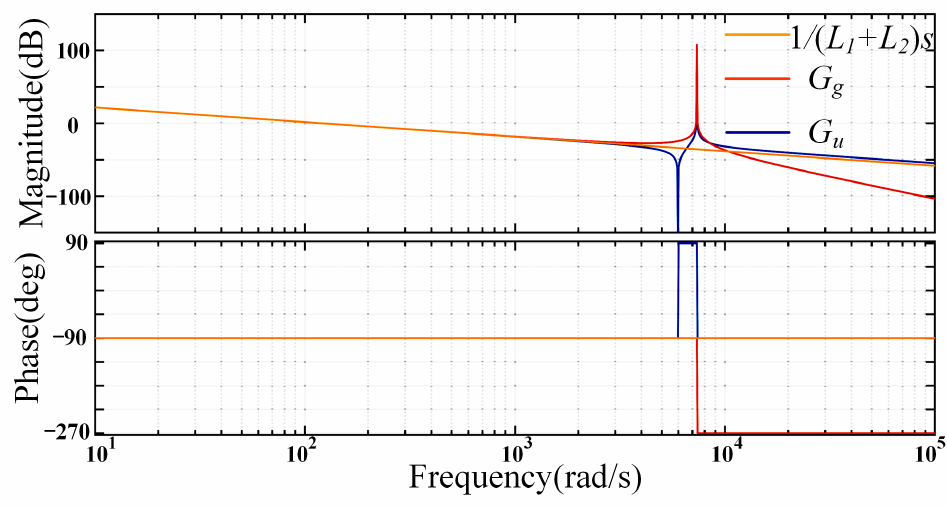
Figure 2. Bode diagrams of i 1 ( s ) / u inv ( s ) , i 1 ( s ) / u g ( s ) , and its reduced-order